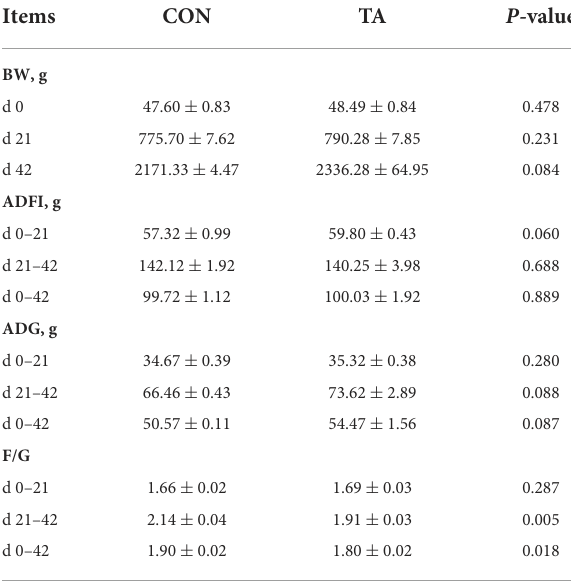
TABLE 3 Effects of dietary supplemented with microencapsulated TA from Galla Chinensis on growth performance of broiler chickens.